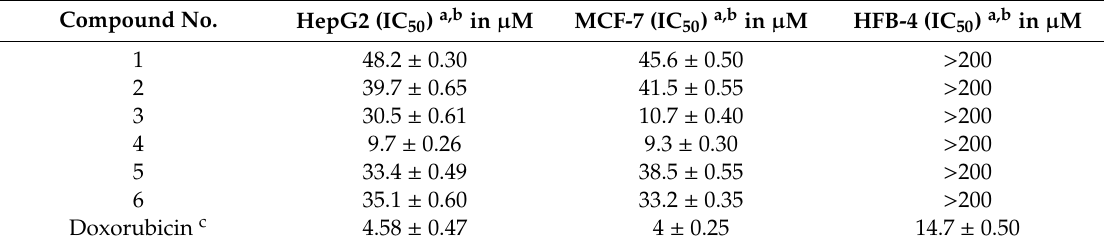
Table 1. Cytotoxic activity of the tested compounds against liver cancer cell line (HepG2), breast cancer cell line (MCF-7) and a human melanocyte (normal cell line) (HFB-4) in